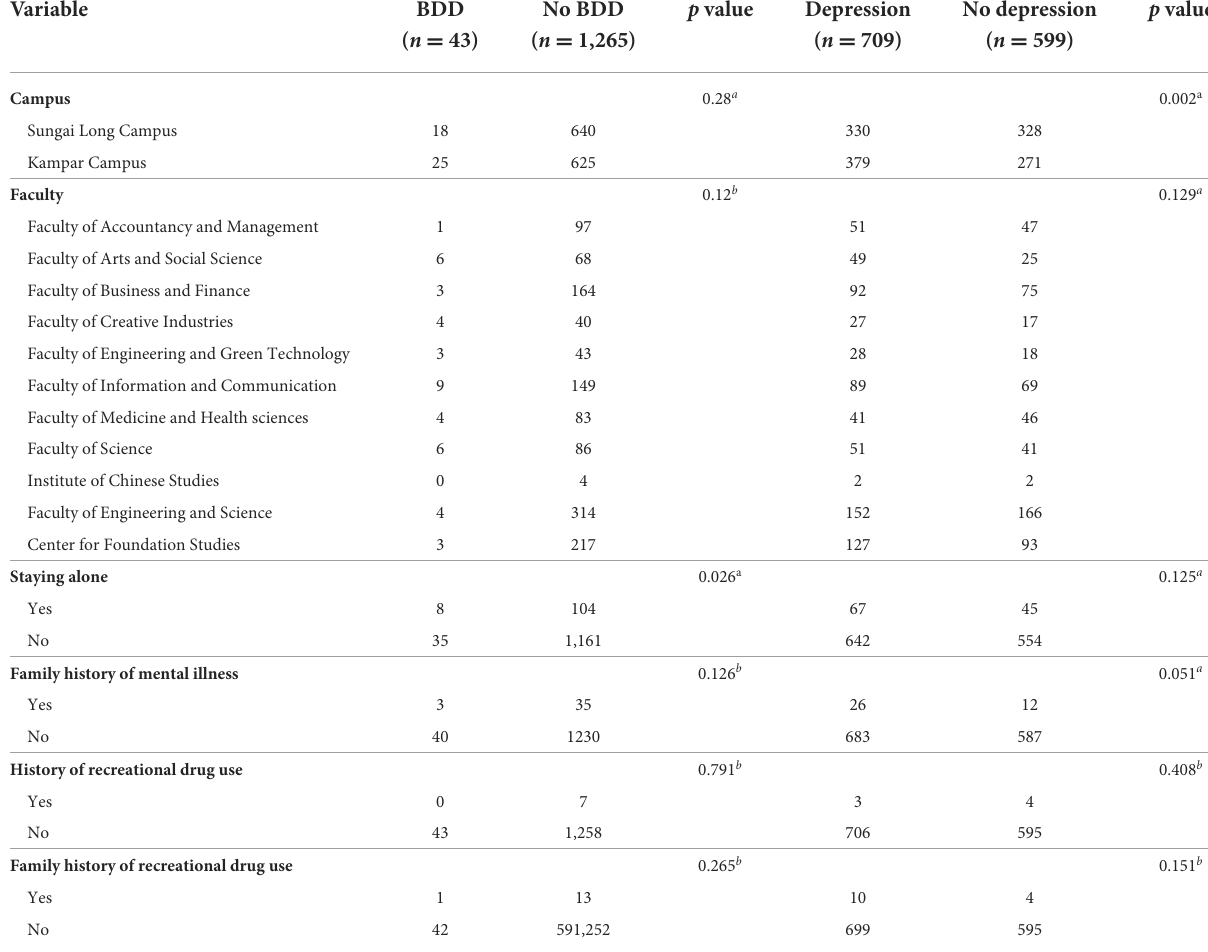
TABLE 1 Socio-demographic parameters of UTAR male undergraduate students according to BDD and depression status.